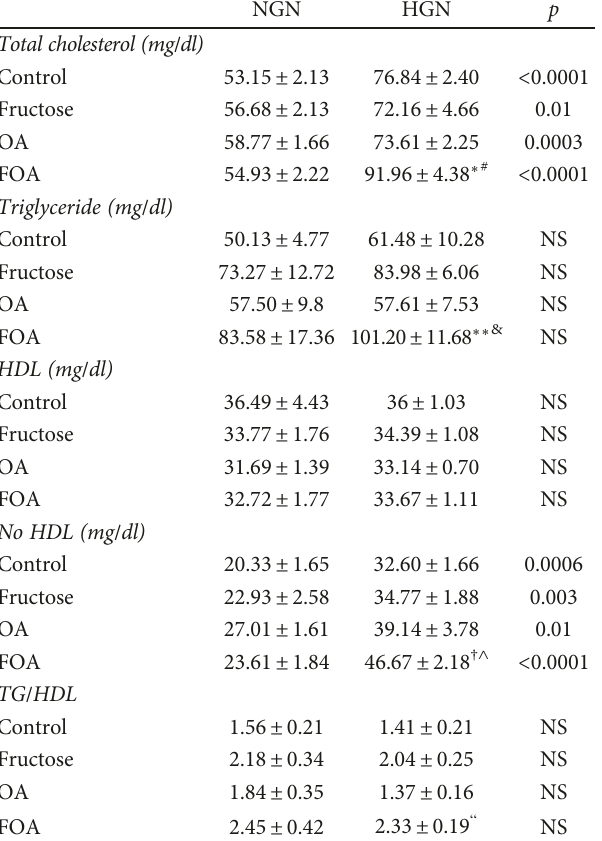
Table 5: Lipid pro fi le. Comparative e ff ect of the gonadal state at di ff erent stages of treatments.